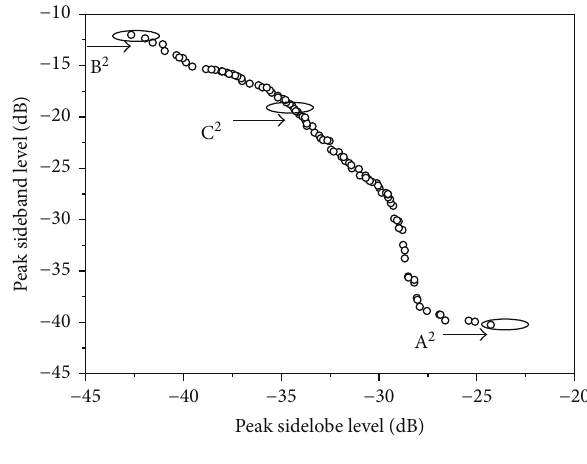
Figure 5: The Pareto front for case 2. Table 4: Performances of three individuals in case 2.